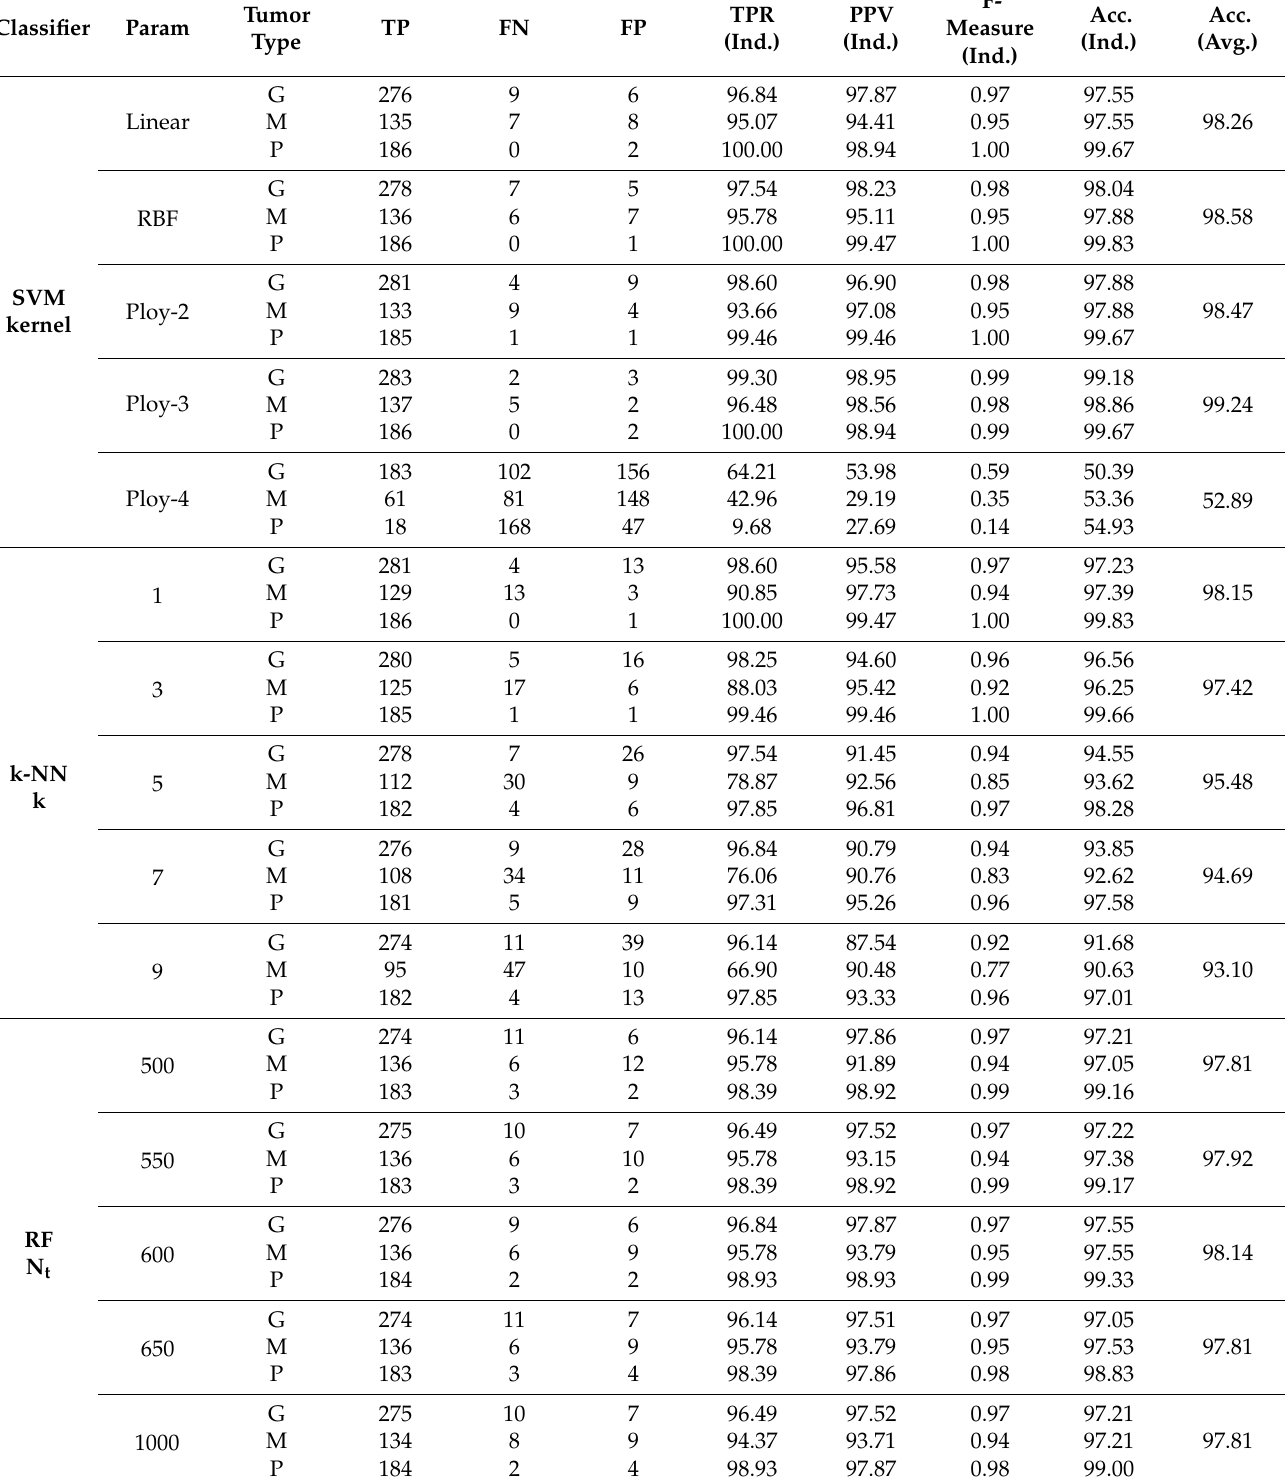
Table 4. Quantitative performance comparison of UL-BTD framework for different ML algorithms using A-CE-MRI dataset with OvA coding scheme (Glioma, Meningioma and Pituitary tumors are being represented as G, M, and P